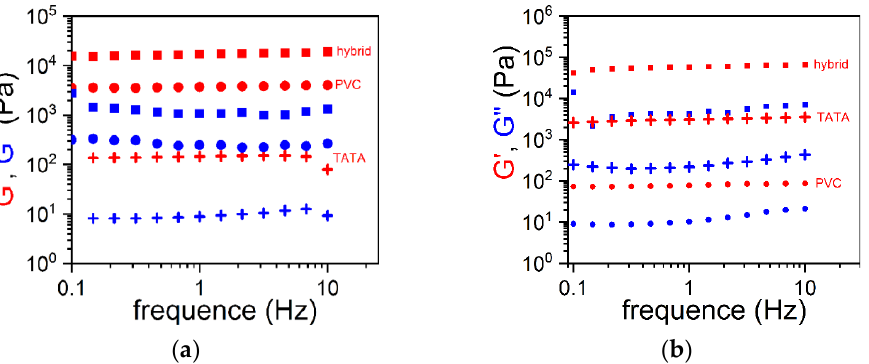
Figure 4. ( a ) Values of the elastic modulus G′ (red symbols) and the loss modulus G” (blue symbols) as a function of the oscillatory frequency for gels prepared in bromobenzene; = TATA/bromoben- zene organogel (C TATA = 0.5 × 10 − 2 g/cm 3 ), = PVC/bromobenzene gels (C PVC = 4.8 × 10 − 2 g/cm 3 ), = hybrid PVCTATA/bromobenzene gel (C TATA = 0.5 × 10 − 2 g/cm 3 , C PVC = 4.8 × 10 − 2 g/cm 3 . ( b ) Values of G ′ (red symbols) and G ″ (blue symbols) as a function of the oscillatory frequency for gels prepared in tetrachloroethane; = TATA/TCE organogel (C TATA = 1.5 × 10 − 2 g/cm 3 ), = PVC/TCE gels (C PVC = 4.8 × 10 − 2 g/cm 3 ), = hybrid PVCTATA/TCE gel (C TATA = 1.5 × 10 − 2 g/cm 3 , C PVC = 4.8 × 10 − 2 g/cm 3 ).